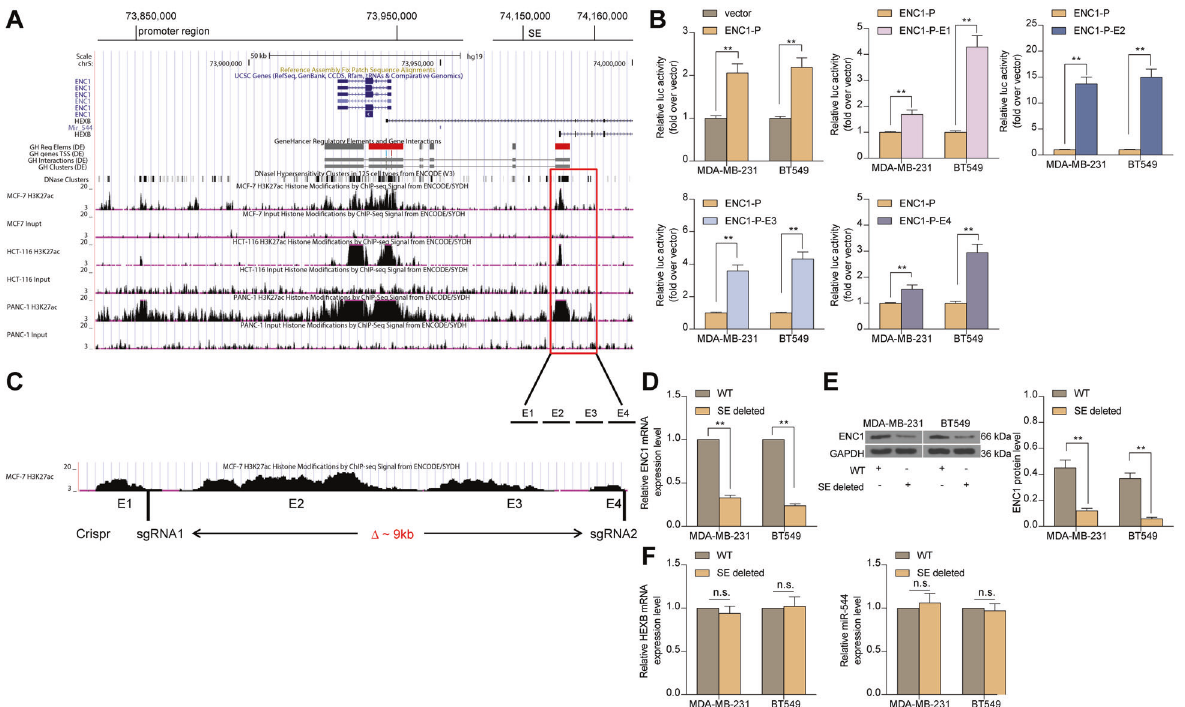
Fig. 4 ENC1 is a SE-driven gene. A H3K27ac levels of ENC1 were examined using the UCSC genome browser. B The luciferase activity of ENC1-P, ENC1-E1, ENC1-E2, ENC1-E3 and ENC1-E4 in MDAMB-231 and BT549 cells measured by luciferase report assay. C The location of two sgRNAs fl anking the 9 kb ENC1-SE distal . D , E RT-qPCR ( D ) and western blot detection ( E ) of ENC1 mRNA and protein expression in MDA-MB-231 and BT549 cells after SE deletion. F RT-qPCR for the expression of HEXB and miR-544, located in the same chromosomal region of ENC1, in MDA-MB-231 and BT549 cells after SE deletion. Data are representative of 3 separate experiments performed in triplicate. All the data are expressed as the mean ± SD. Two-way ANOVA (panel B, D-F) with Tukey ’ s multiple comparison test were utilized to detect signi fi cant differences between data. ** p < 0.01, ns, nonsigni fi